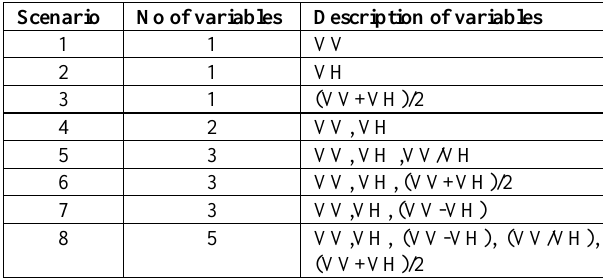
Figure 4. Classification result of VH image.